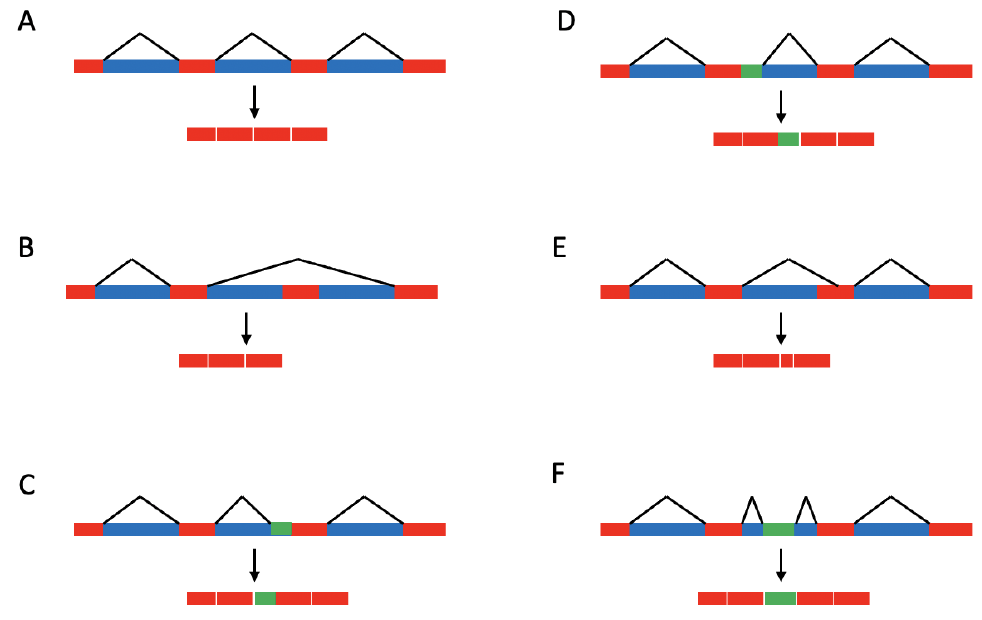
Figure 2. Commonly observed alternative splicing patterns of pre-mRNAs. ( A ). Normal splicing. The upper figure represents pr-mRNA with exons (red) and introns (blue). The lower figure represents mature mRNA consisting of joined exons following the splicing pattern indicated by the black